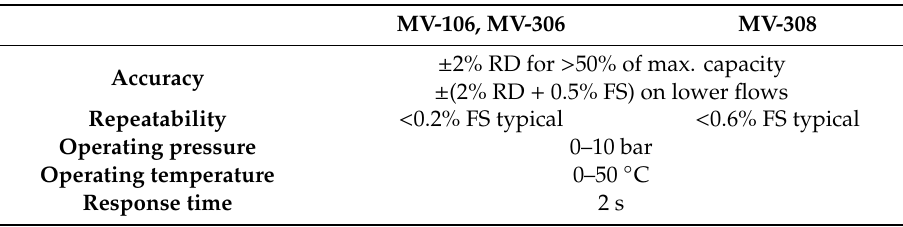
MV-308 [36]. FS = full scale; RD = reading.